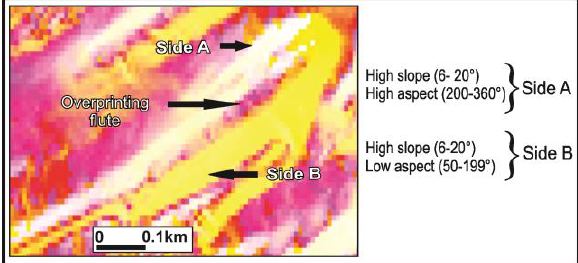
Figure 5. Submarine drumlins in “Merged Image I” (elevation- red channel, slope-green channel, aspect- blue